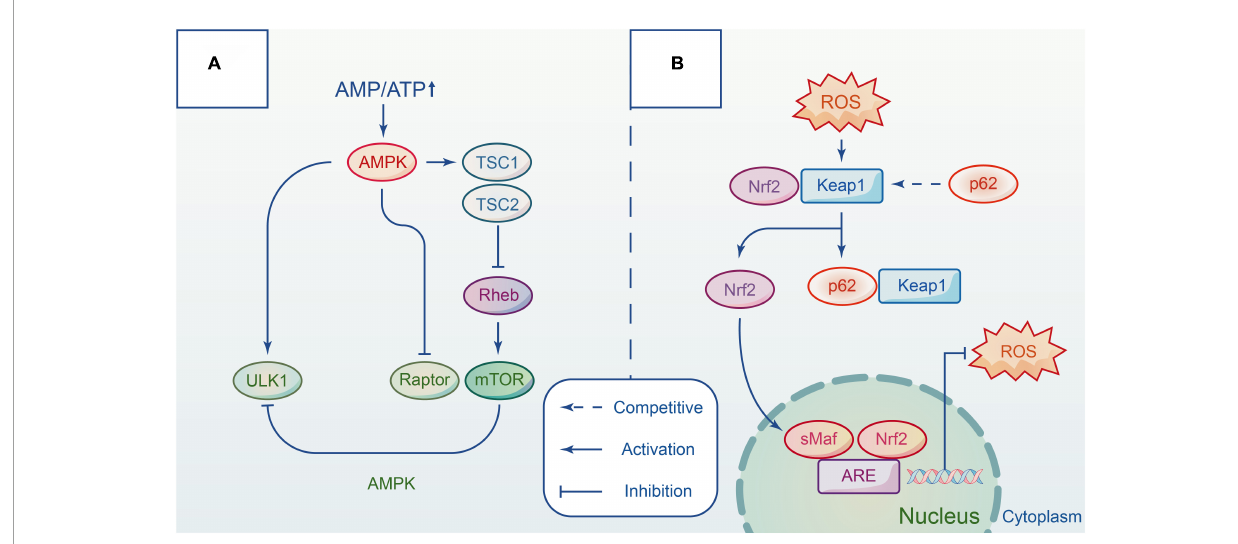
FIGURE2 The main pathways involved in autophagy by interacting with different complexes. (A) Autophagy is regulated by AMPK and mTOR signaling pathway in different ways. Upon the energy depletion, AMPK responds to energy changes, and repress mTORC1 to modulate ULK1 activity and induce autophagy. (B) Keap1-Nrf2 signal pathway is a defense mechanism to protect the body from oxidative stress. The adaptor protein p62 competitives with NRF2 and forms a p62-KEAP1 complex. Hence, Nrf2 accumulates in the cytoplasm and then translocates to the nucleus to initiate transcription, which provides an antioxidant action. Repress mTORC1 to modulate ULK1 activity and induce